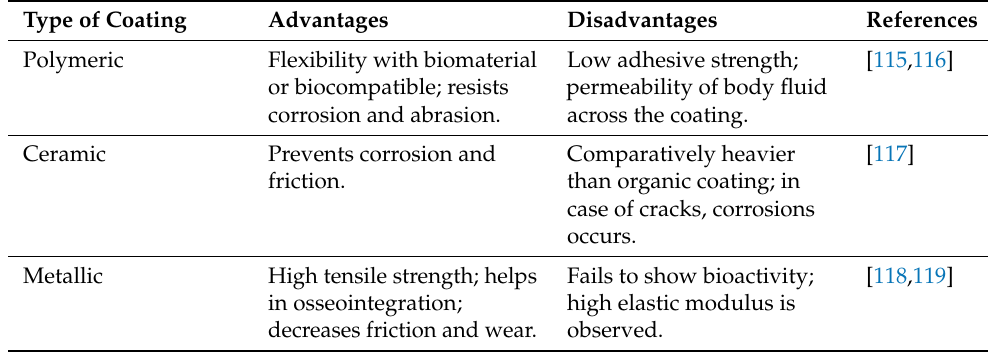
Table 3. Advantages and disadvtanges of three commonly used coating on